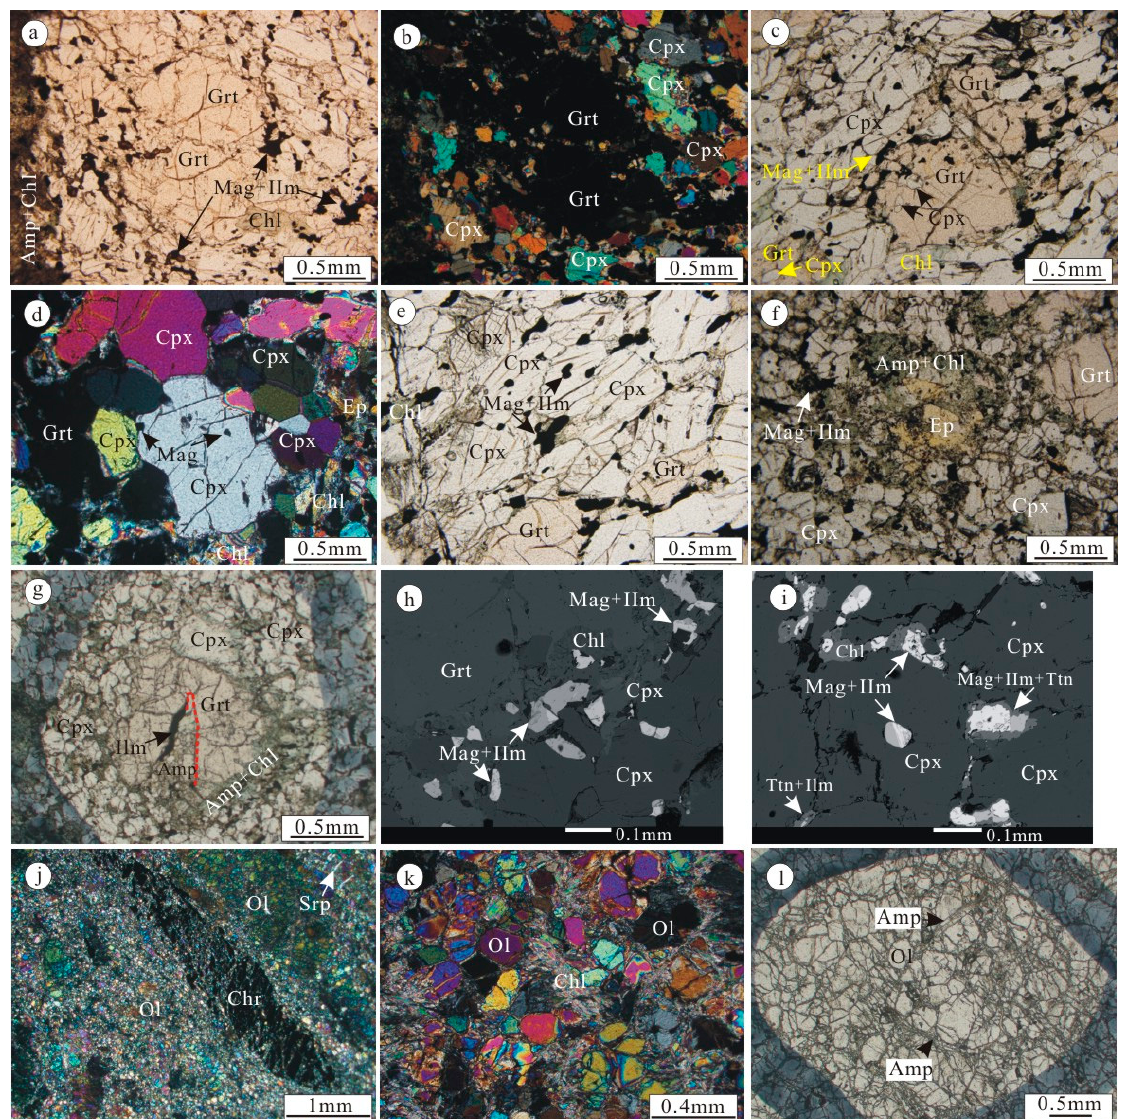
Figure 2. Photomicrographs of garnet pyroxenite and dunite at Hujialin in the Sulu orogen, showing mineral assemblages and characteristic textures. ( a , b ) Type-1 and type-2A clinopyroxenite show porphyroblastic texture. ( c ) Clinopyroxene occurs as inclusions in garnet and isolated grains. ( d ) Euhedral to anhedral clinopyroxene. ( e ) Clinopyroxene grains are elongated and show preferred orientation in some samples. ( f ) Garnet-poor clinopyroxenite composed of clinopyroxene, garnet, alteration minerals, Fe-oxides, and titanite. ( g ) Clinopyroxene, minor amphibole, and Fe-oxides are included in garnet. ( h , i ) Fe-oxides and titanite intergrowths occur in interstital spaces of other minerals. ( j – l ) Dunite consists of olivine and chromite. Some chromite grains show preferred orientation. Amp = amphibole; Chl = chlorite; Chr = chromite; Cpx = clinopyroxene; Ep = epidote; Grt = garnet; Ilm = ilmenite; Mag = magnitite; Ol = olivine; Srp = serpentine; Ttn = titanite. Mineral abbreviations after Whitney and Evans [30].